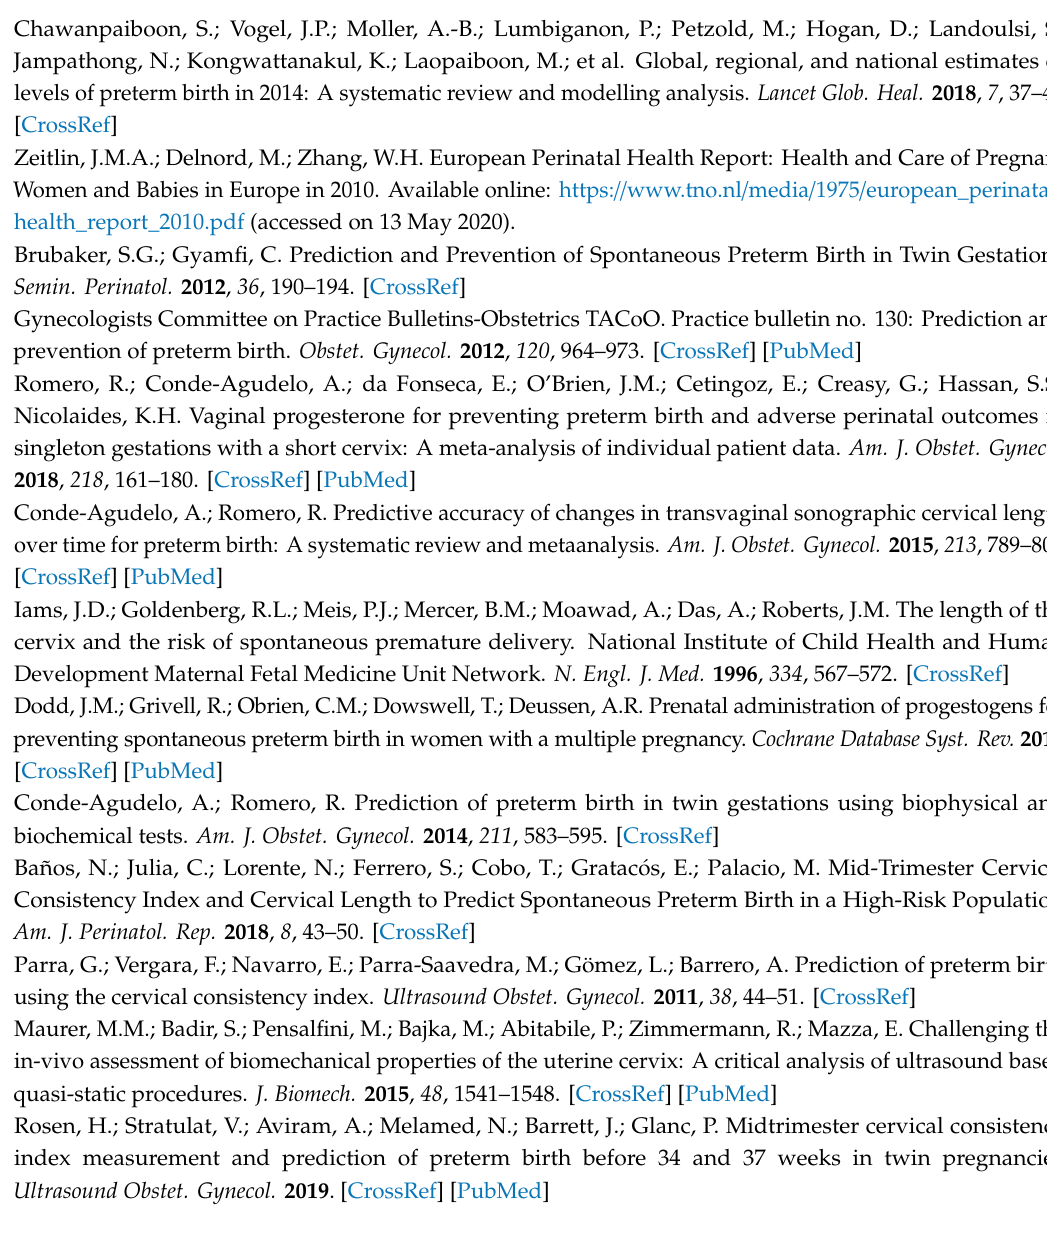
Figure S1: Distribution plots with density line indicated of the ultrasound derived markers at mid trimester with correlation plots between respective markers. Figure S2: Plot of the ultrasound derived markers at mid trimester against the gestational age at delivery. Goodness of fit indicated by R 2